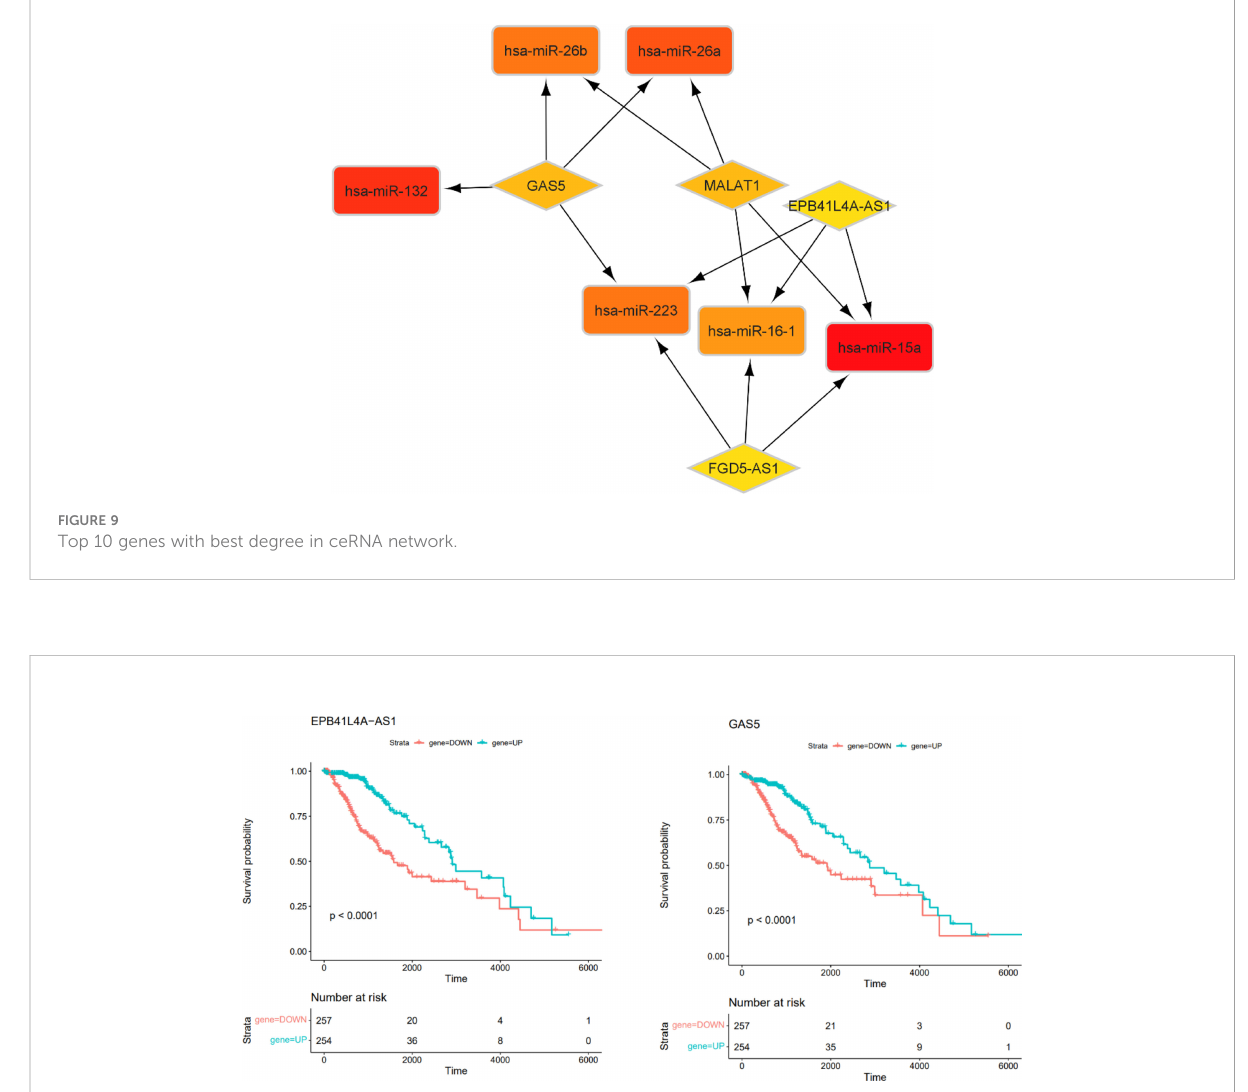
FIGURE 10 Kaplan – Meier survival curves of DElncRNAs associated with overall survival of patients with low grade glioma.